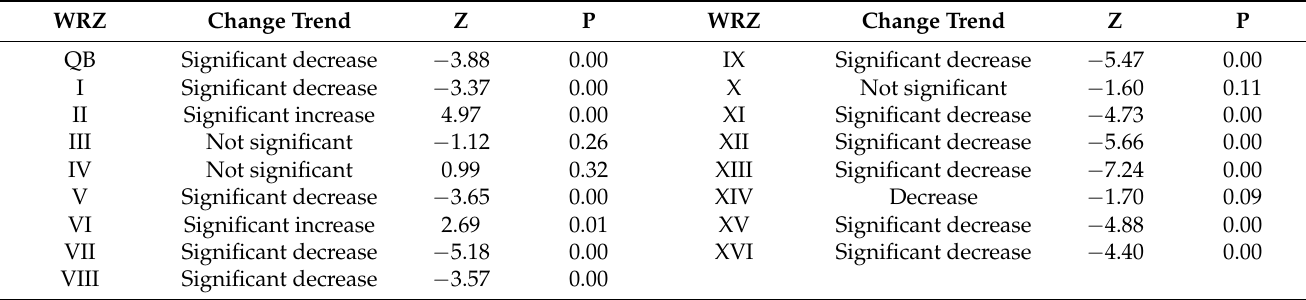
Table 8. Test results of the trend towards cropland area in the Qaidam Basin from 1990 to